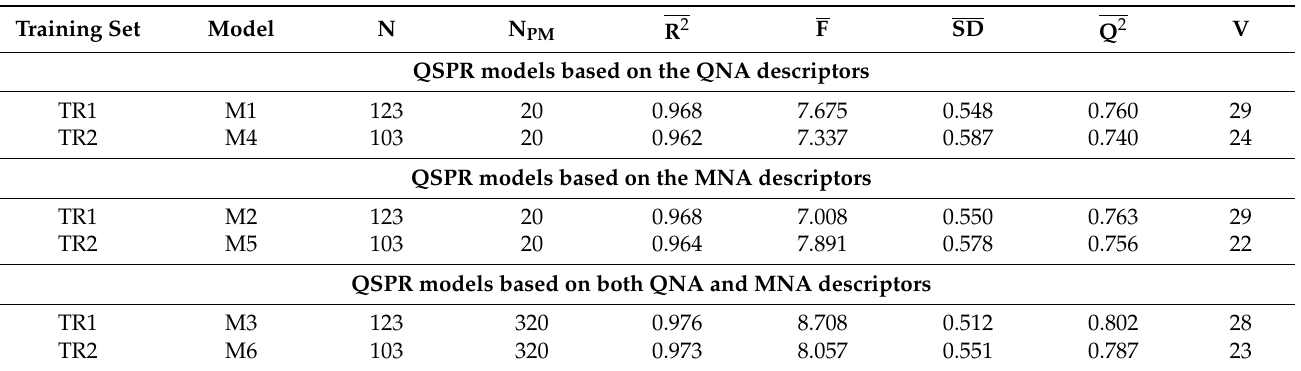
Table 1. Statistical parameters and the accuracy of the predicted logk 7 values of the compounds included in the training sets TR1, TR2 within the M1–M6 consensus models (using Both). ∆ logk 7(TR1) = ∆ logk 7(TR2) = 7.057 1